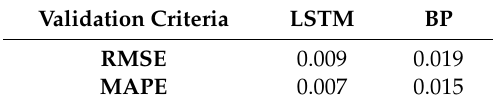
Table 3. Validation criteria results.